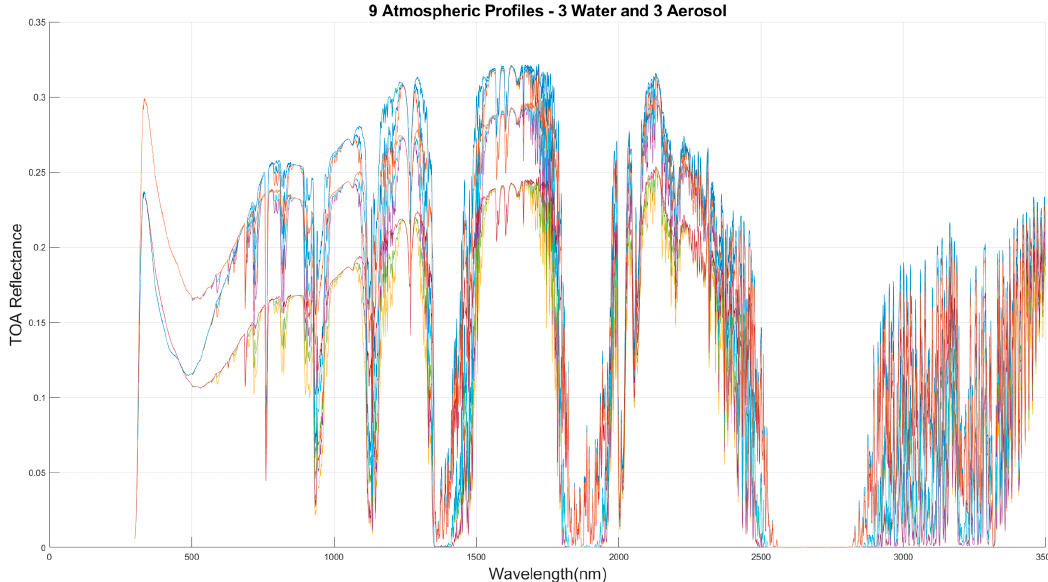
Figure 15. Barren3 atmospheric profiles for spectral uncertainty analysis. Note there are three aerosol profiles and three water absorption profiles, which, combined, give a total of nine combinations. This large range of atmospheric profiles gave the spectral uncertainty analysis enough simulations to cover all possible scenarios during the underfly. Table 10. Spectral uncertainty table. Uncertainty units are reflectance.